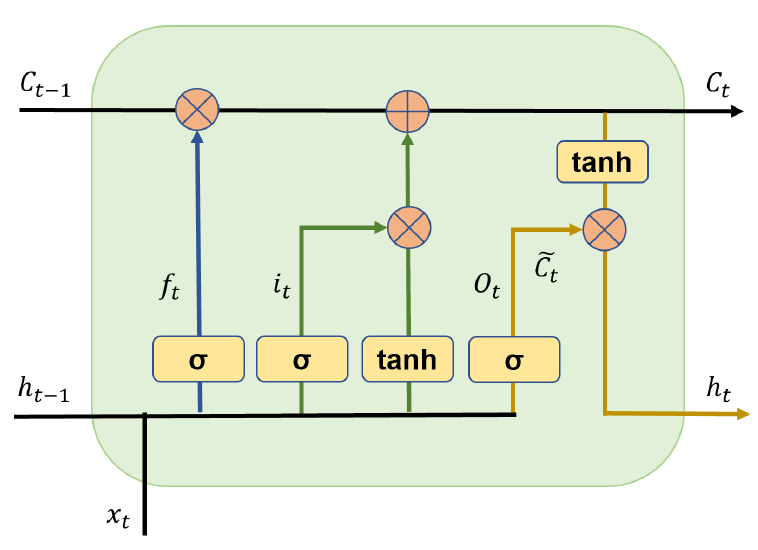
Figure 5. The basic structure of